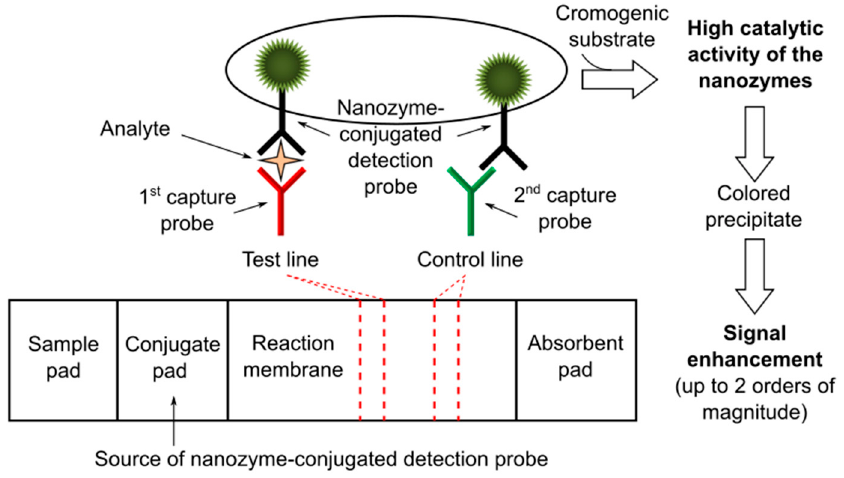
Figure 5. Schematics of a LFT based on the use of nanozymes, e.g., platinum (Pt) nanoparticles, as labels for signal enhancement.